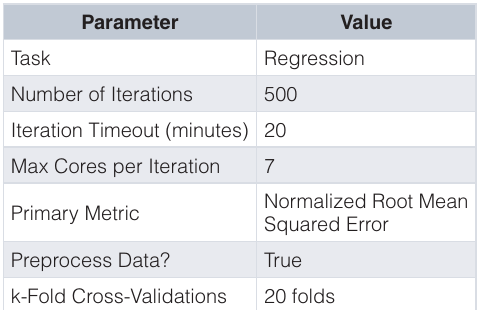
Table 4. Model search parameter setting for the